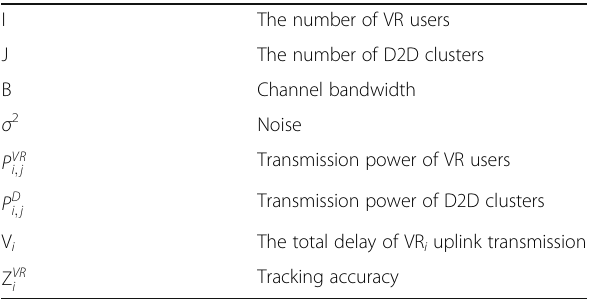
Table 1 Parameters of